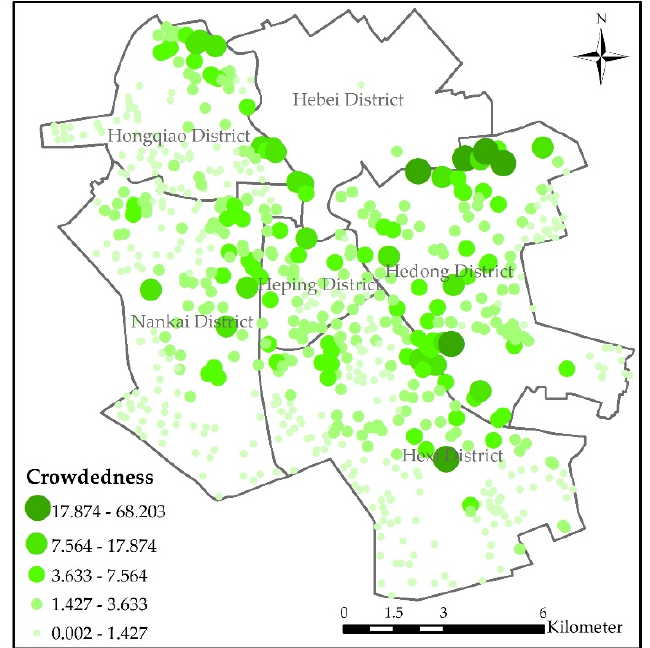
Figure 11. Crowdedness distribution at the beginning of A-2SFCA’s stage 1 method.